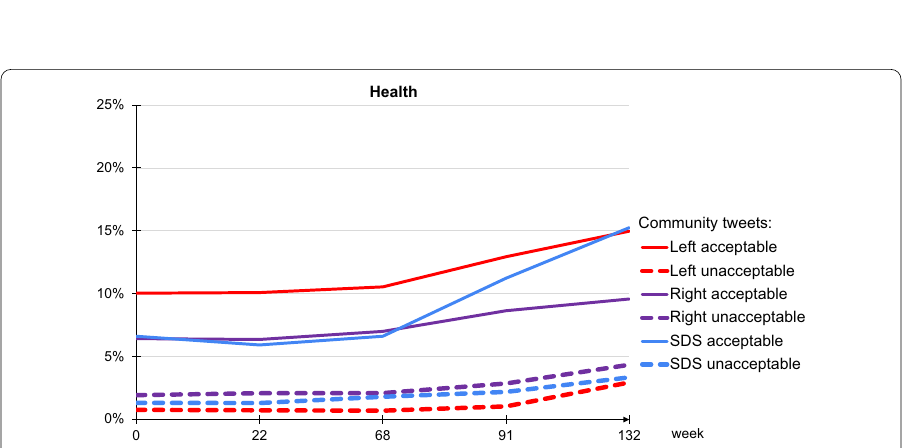
Fig. 7 Evolution of the health topic, including the Covid-19 pandemic, for the three major communities: Left (red), Right (violet), and SDS (blue). Solid lines represent acceptable tweets, and dashed lines correspond to unacceptable tweets. The y-axis represents percentages of tweets with a topic of health out of all the tweets posted or retweeted by a community. Note that the range of the y-axis here is half the range of the y-axis in Fig. 6. The x-axis are the five timepoints at weeks t =